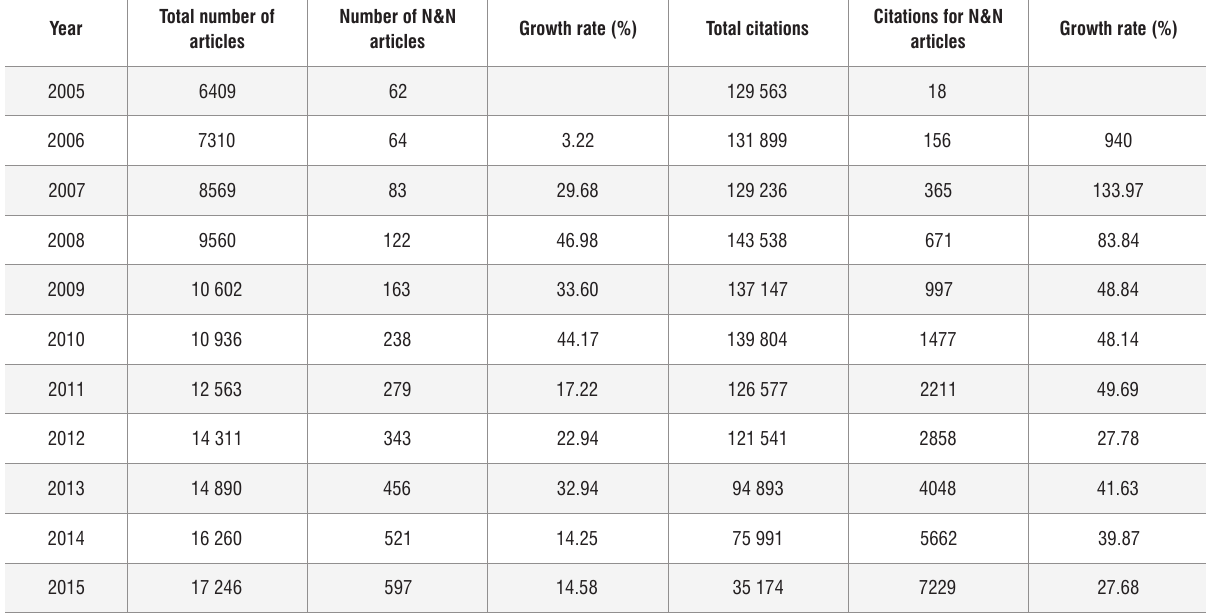
Table 1: South Africa’s publication and citation trends in the field of nanoscience and nanotechnology (N&N) and growth rates for